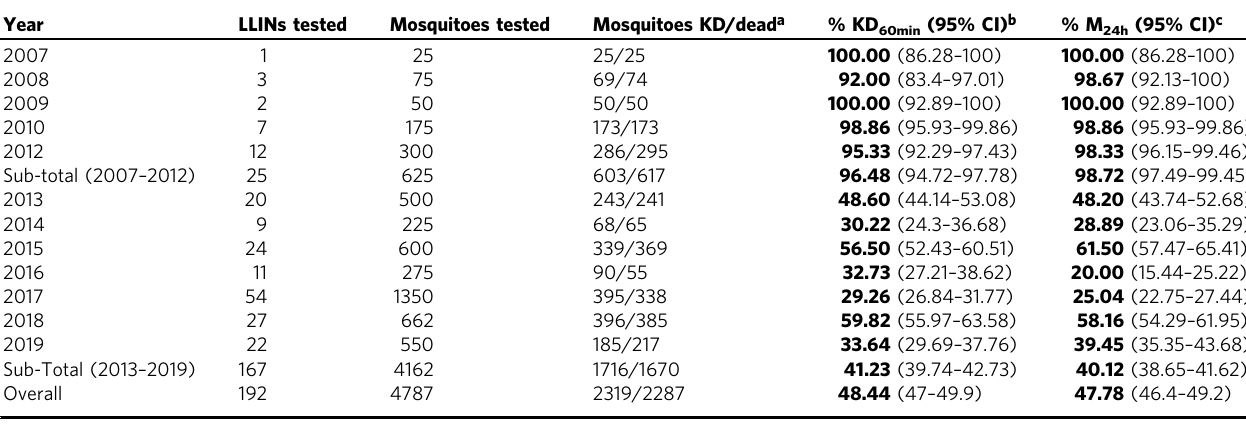
Table 1 Number of new and unused LLINs and number of mosquitoes tested per year of LLIN manufacture, and resulting mosquito knockdown and